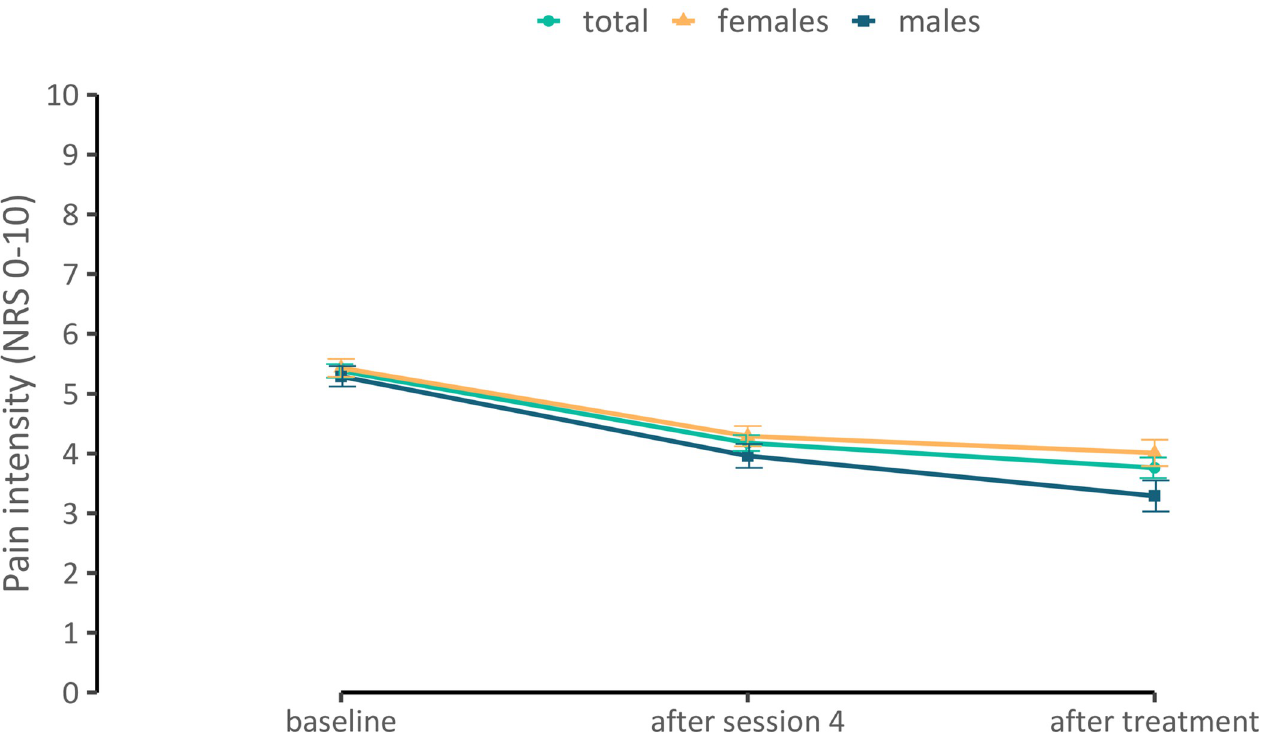
Fig 2. Pain intensity at baseline, after four sessions and after the end of the acupuncture treatment displayed for total sample, males, and females.